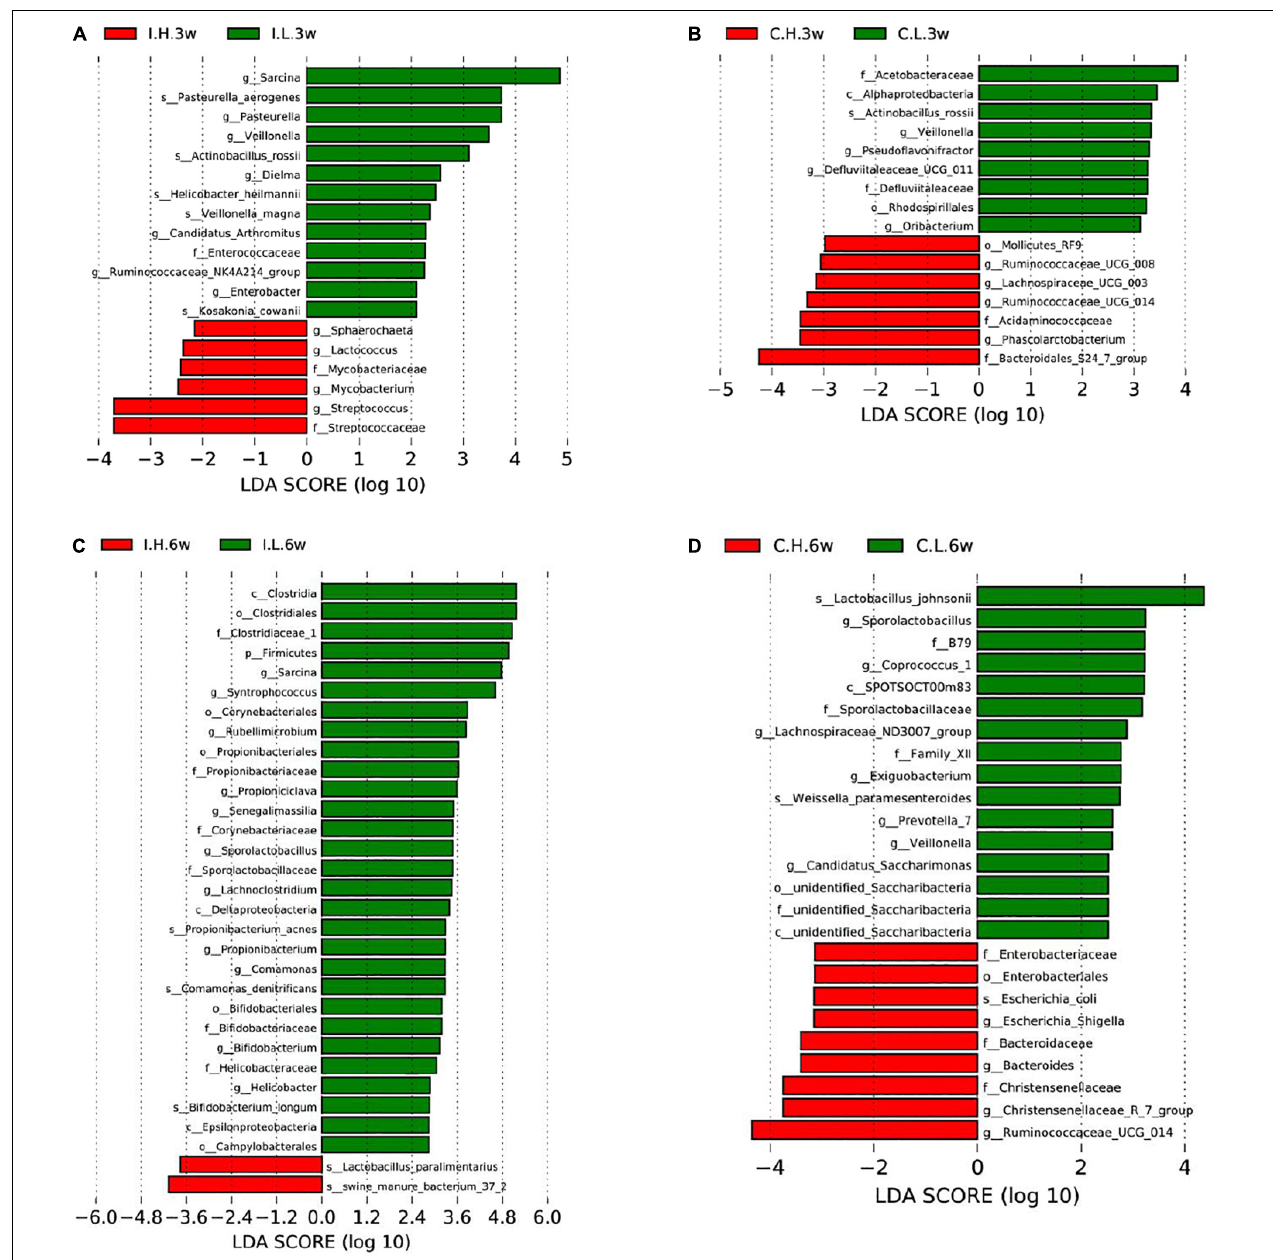
FIGURE 2 | Significantly different compositions of the ileal and cecal microbiota between control and Cu-supplemented groups determined by linear discriminant analysis (LDA) effect size analysis after 3 and 6 weeks of feeding in weaned piglets. Significantly different compositions of the ileal (A) and cecal (B) microbiota after 3 weeks of feeding and significantly different compositions of the ileal (C) and cecal (D) microbiota after 6 weeks of feeding. I, ileal microbiota; C, cecal microbiota; L, control group; H, Cu-supplemented group; 3w, 3 weeks of feeding after weaning; 6w, 6 weeks of feeding after weaning.